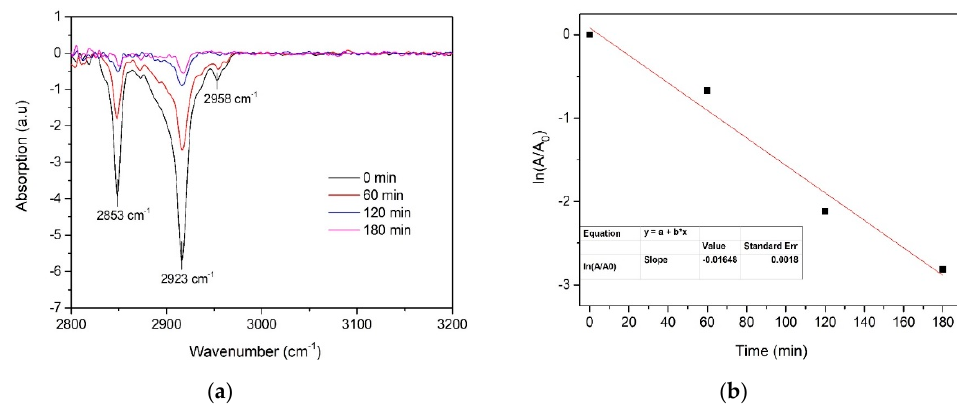
Figure 7. ( a ) FTIR spectra of stearic acid on the surface of TiO 2 thin-film-deposited 0.1 M solution using 7 spray cycles and ( b ) the determination of the photodegradation rate constant (k).